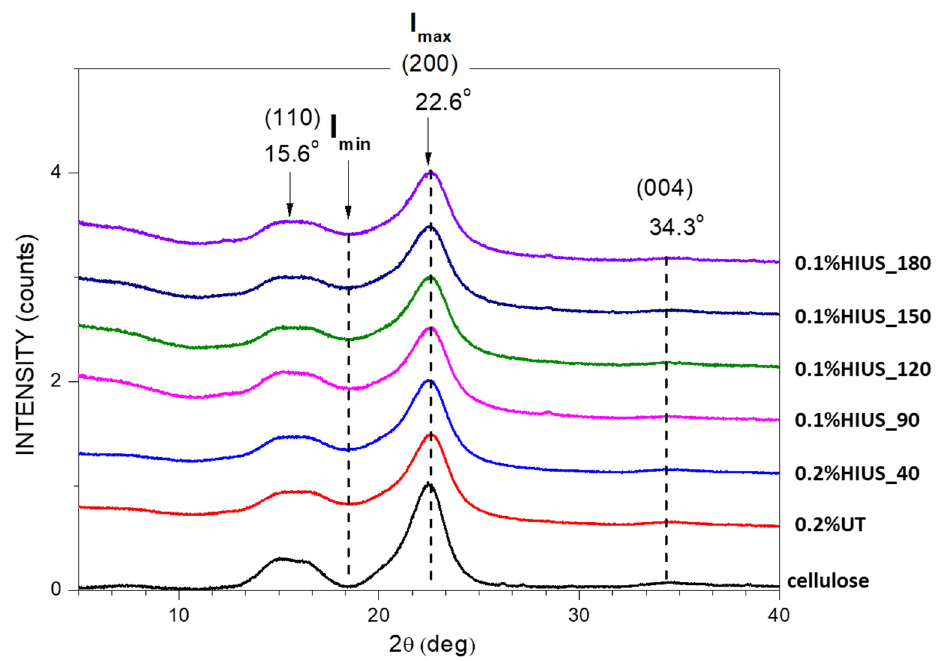
Figure 3. X-ray diffraction pattern of cellulose isolated for hop stems before (cellulose, 0.2%UT) and after HIUS treatment. The main diffraction reflections with Miller indices of dominant planes are denoted in the graph.